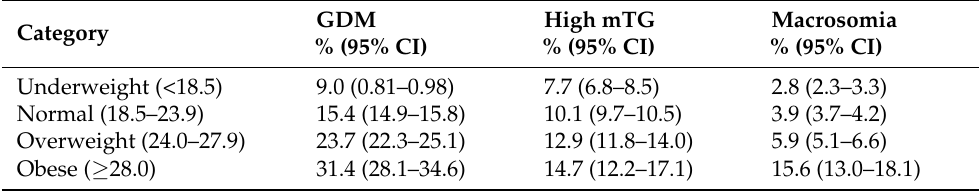
Table 2. The prevalence of high mTG levels, GDM and macrosomia in each BMI group.